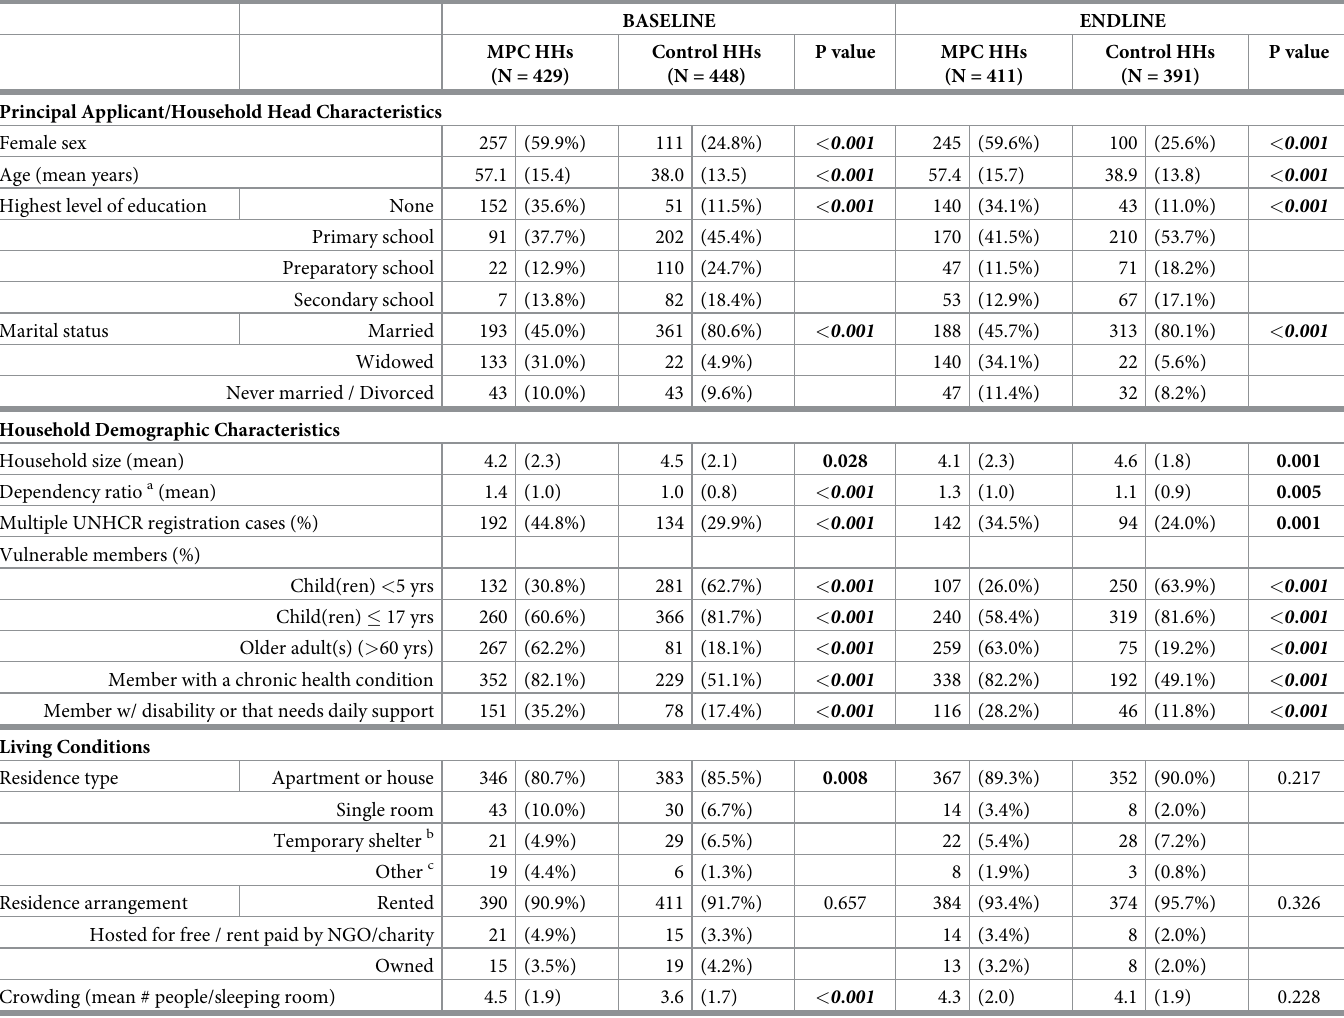
Table 2. Sample demographic characteristics and living conditions at baseline and